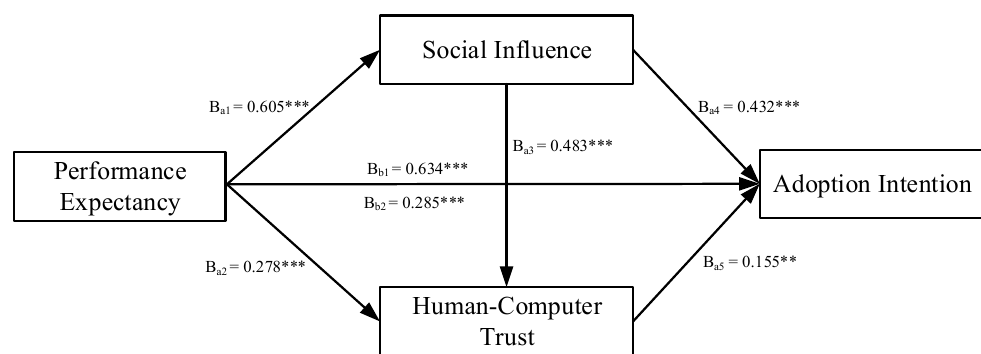
Figure 2. The serial multiple mediation model of performance expectancy. Note: a1, direct effect of performance expectancy on social influence; a2, direct effect of performance expectancy on human-computer trust; a3, direct effect of social influence on human-computer trust; a4, direct effect of social influence on adoption intention; a5, direct effect of human-computer trust on adoption intention; b1, total effect of performance expectancy on adoption intention; b2, direct effect of performance expectancy on adoption intention. ** p < 0.01; *** p < 0.001.